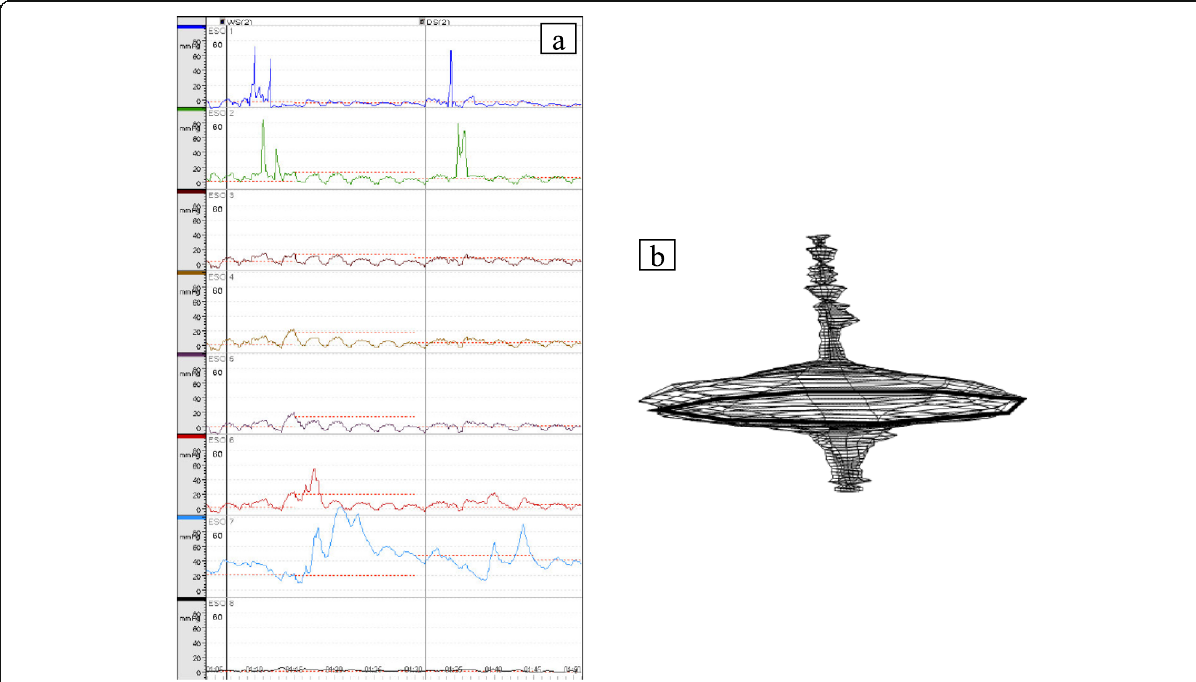
Fig. 2 Preoperative esophageal manometry findings. a Intra-esophageal pressure measurement showing a high lower esophageal sphincter pressure and normal peristaltic waves. b The vector volume is very high (23,972 mmHg 2 cm)